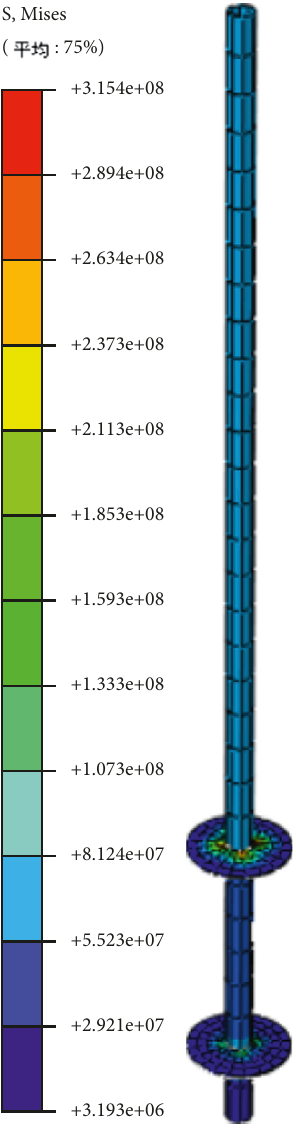
Figure 7: Stress distribution of screw